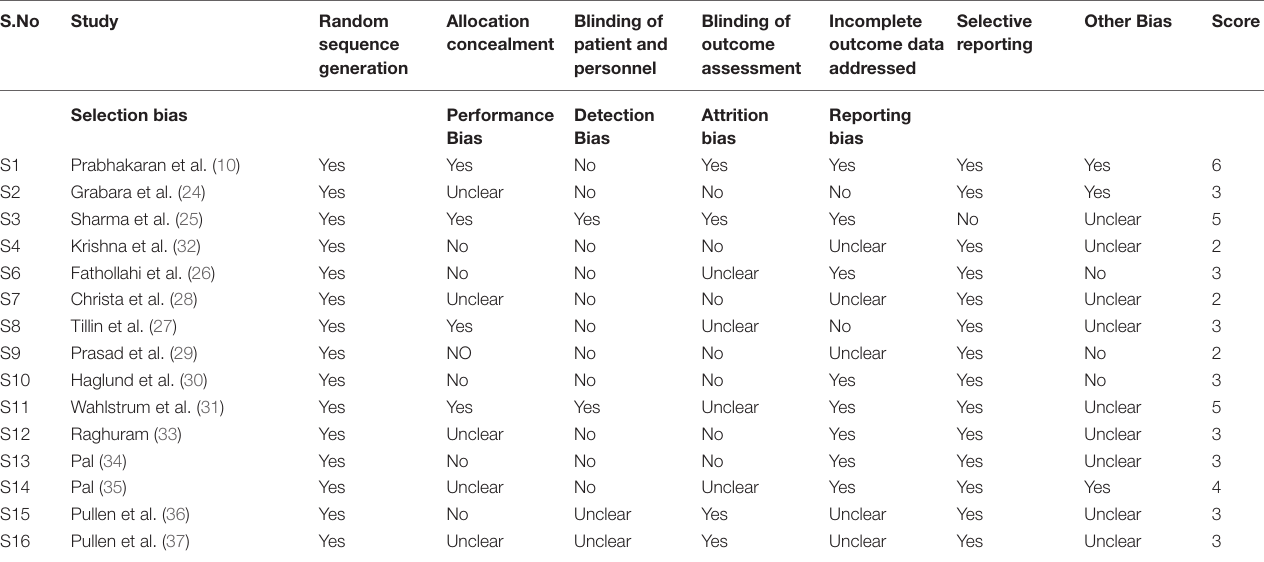
( Figure 2 ). Description of physical and psychological outcomes of selected studies are shown in Table 4